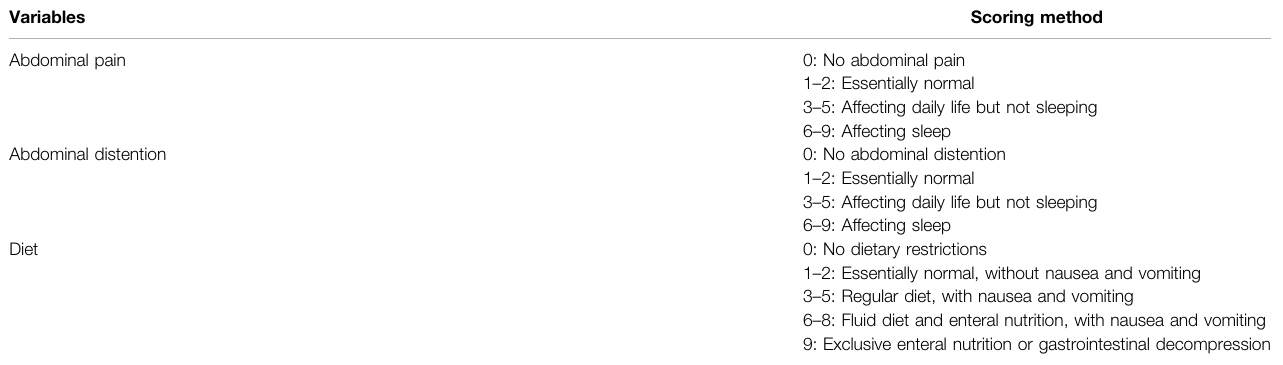
TABLE 1 | De fi nition of each target and scoring method in patients.